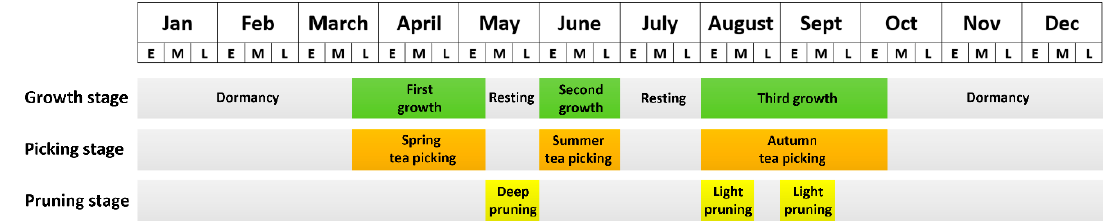
Figure 2. Annual growth, picking, and pruning stages of tea in the study area delineated by the first ten (E), middle ten (M), and last ten (L) days of each month.